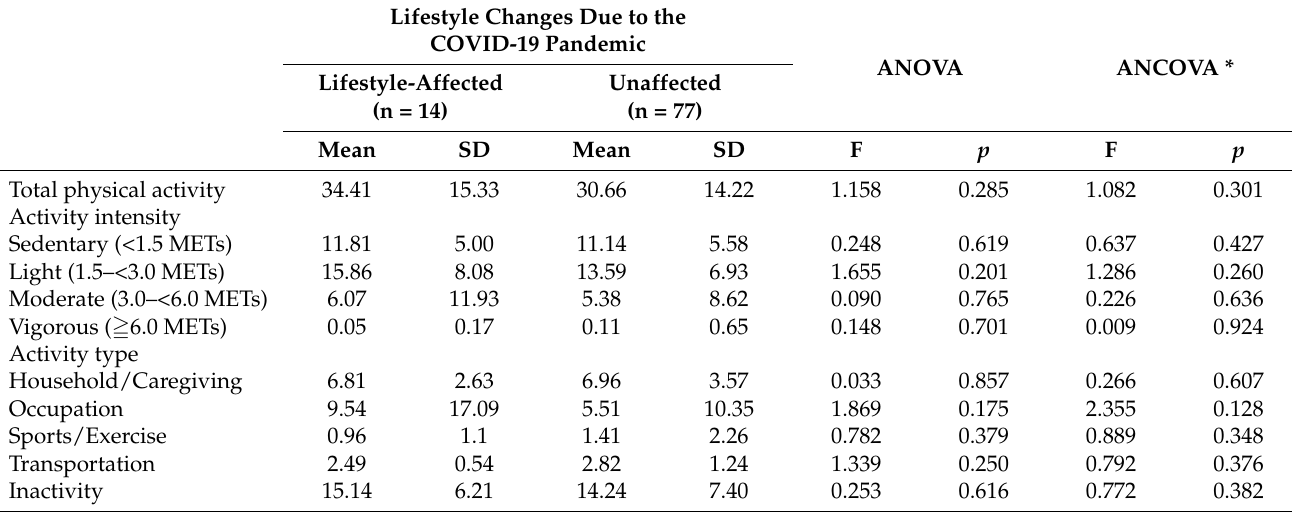
Table 5. Differences in physical activity levels between the lifestyle-affected and unaffected groups in primiparas (n = 91). Lifestyle Changes Due to